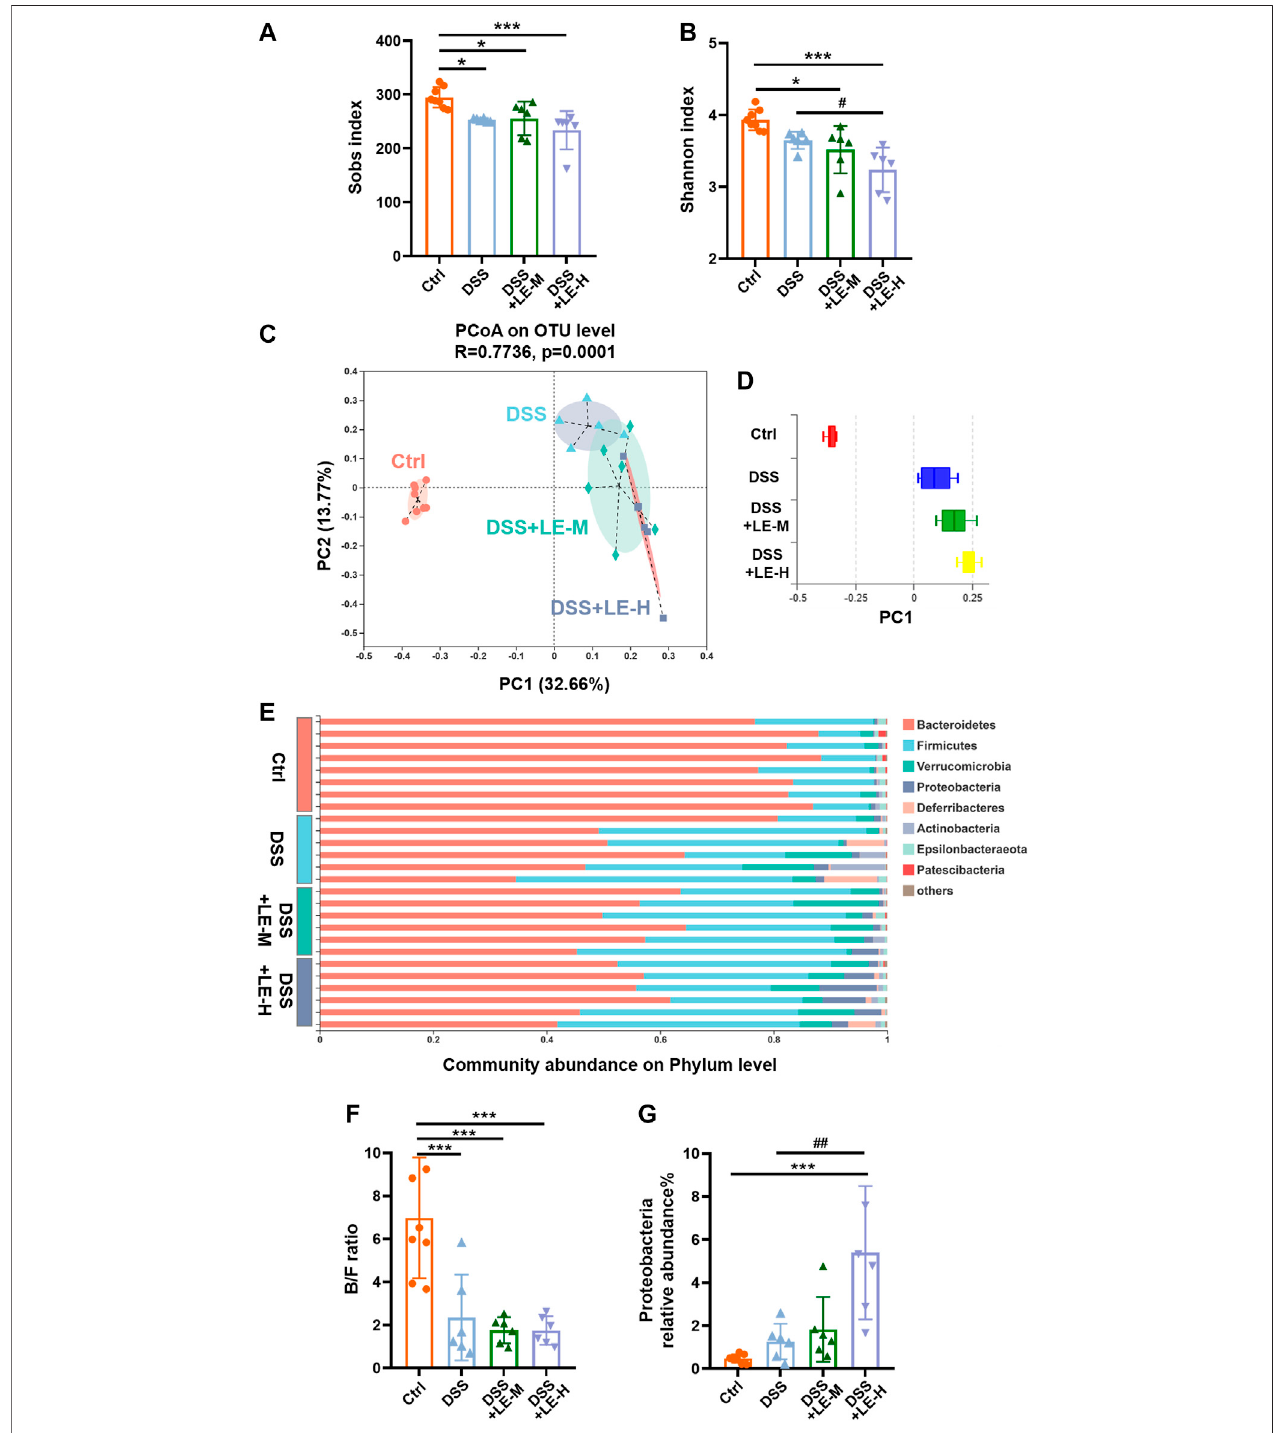
FIGURE6| Structuralrearrangementofcolonicmicrobialcommunityafterexcessivelongantreatmentincoliticmice. (A) Sobsindex. (B) Shannonindex. (C) PCoA analysis based on OTU level and (D) discrete degree of PC1. (E) Community abundance on phylum level. (F) Ratio of Bacteroidetes/Firmicutes (B/F). (G) Relative abundance of Proteobacteria. Data are presented as mean ± SD ( n (cid:1) 8 for Ctrl group; n (cid:1) 6 for other groups). * p < 0.05, ** p < 0.01, *** p < 0.001, compared to Ctrl; # p < 0.05, ## p < 0.01, compared to DSS group.